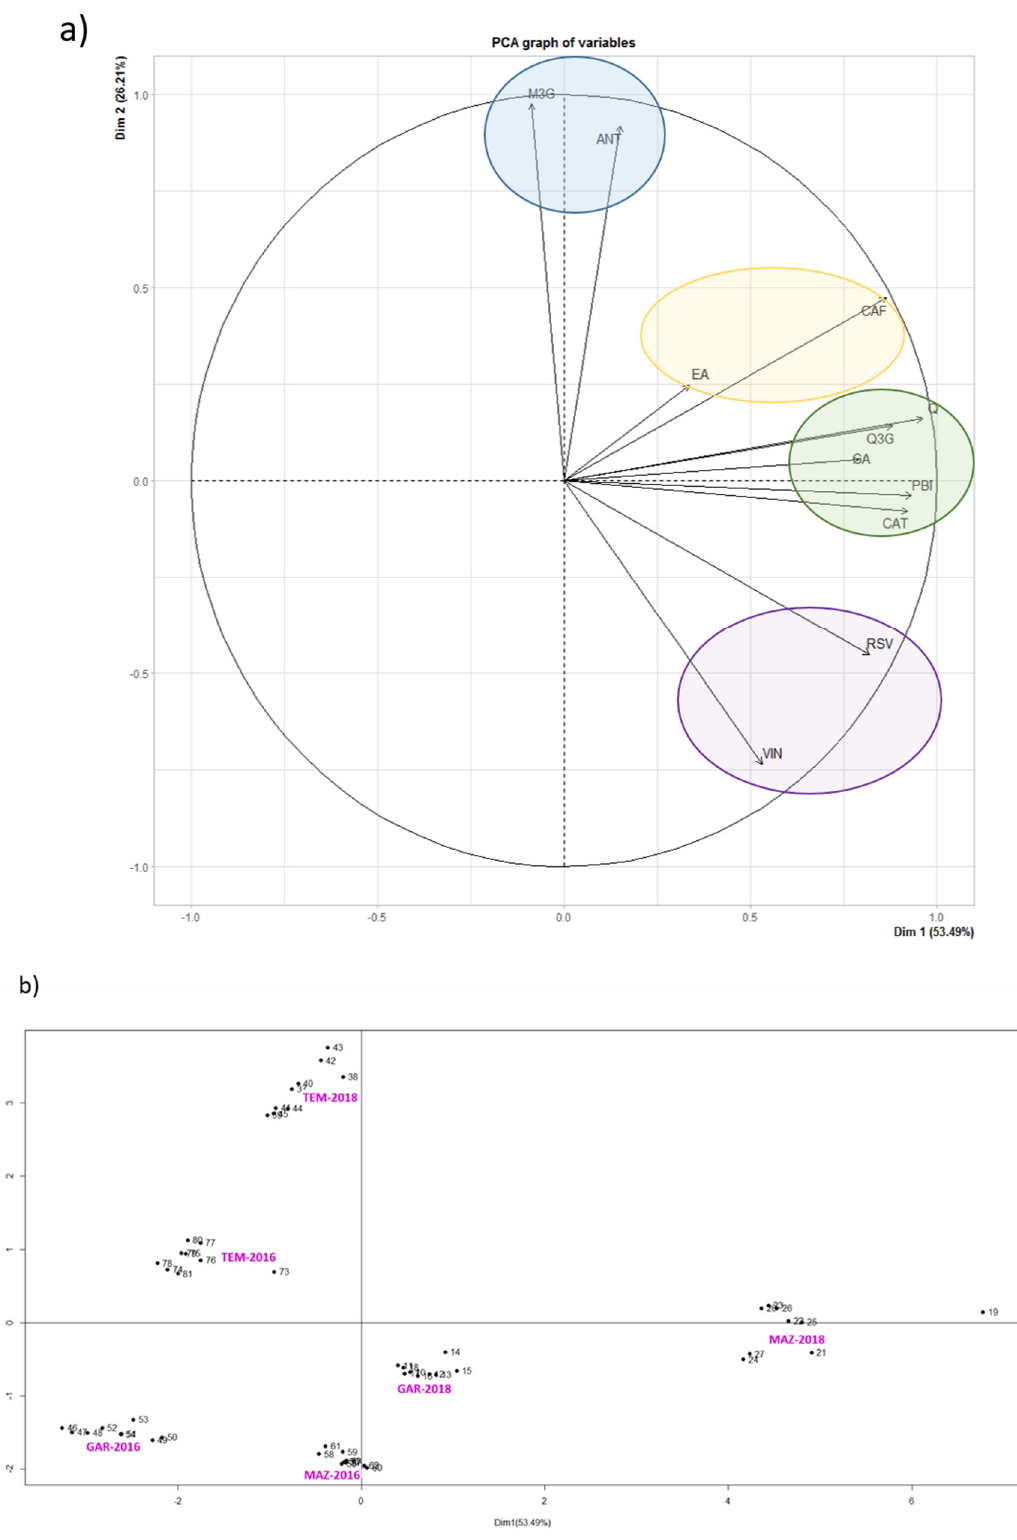
Figure 1. Principal component analysis (PCA) of phenolic compounds of grape stem extracts from Mazuelo, Garnacha and Tempranillo varieties from vintages 2016 and 2018. ( a ) Variables graph: GA (gallic acid); CAT (catechin); Q (quercetin); Q3G (quercetin-3-derivative); M3G (malvidin-3-glucoside); ANT (unknown anthocyanin); RSV (trans-resveratrol); VIN ( ε -viniferin); CAF (caftaric acid); EA (elagic acid); PB1 (procyanidin B1); ( b ) Individuals factor map. Individuals (Mazuelo 2016 and Mazuelo 2018; Graciano 2016 and Graciano 2018; Tempranillo 2016 and Tempranillo 2018) are presented in pink